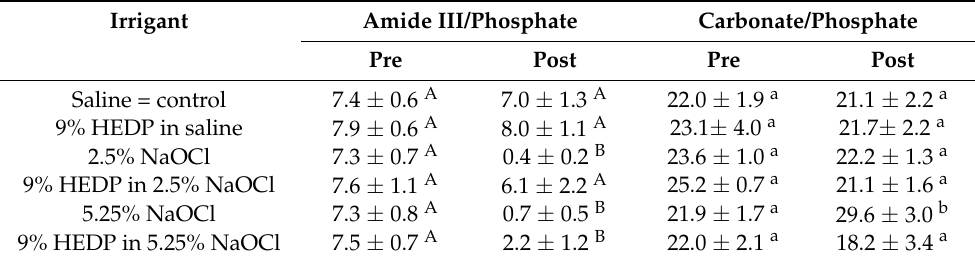
Table 1. FTIR ratios (values are multiplied by 1000) before (pre) and after (post) 30 min of immersion in the different irrigants. Irrigant Amide III/Phosphate Carbonate/Phosphate Pre Post Pre Post Saline = control 7.4 ± 0.6 A 7.0 ± 1.3 A 22.0 ± 1.9 a 21.1 ± 2.2 a 9% HEDP in saline 7.9 ± 0.6 A 8.0 ± 1.1 A 23.1 ± 4.0 a 21.7 ± 2.2 a 2.5% NaOCl 7.3 ± 0.7 A 0.4 ± 0.2 B 23.6 ± 1.0 a 22.2 ± 1.3 a 9% HEDP in 2.5% NaOCl 7.6 ± 1.1 A 6.1 ± 2.2 A 25.2 ± 0.7 a 21.1 ± 1.6 a 5.25% NaOCl 7.3 ± 0.8 A 0.7 ± 0.5 B 21.9 ± 1.7 a 29.6 ± 3.0 b 9% HEDP in 5.25% NaOCl 7.5 ± 0.7 A 2.2 ± 1.2 B 22.0 ± 2.1 a 18.2 ± 3.4